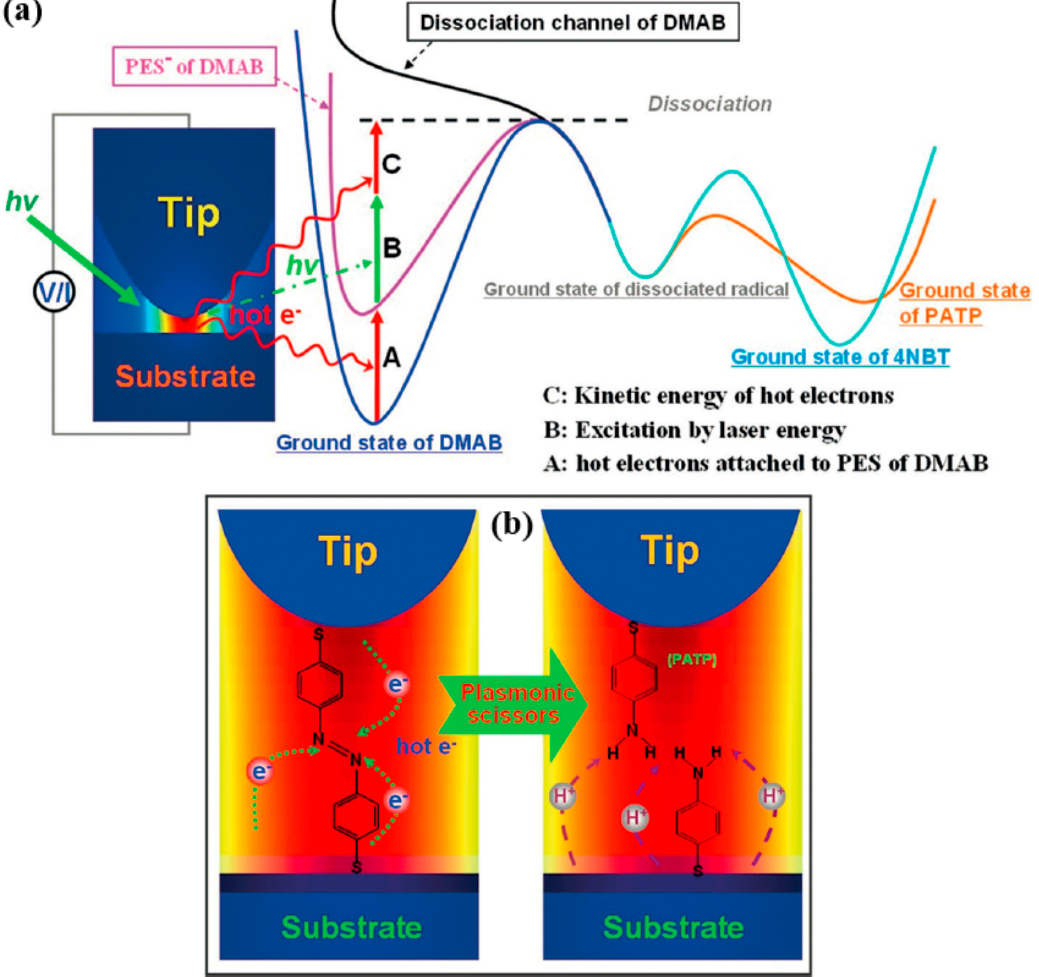
Figure 11. The process of pH control of products of the dissociation by plasmonic scissors in HV-TERS. ( a ) Scheme of reaction paths, in accordance with experimental results. ( b ) Dynamic process of chemical reaction under acidic conditions. Adapted from [11].